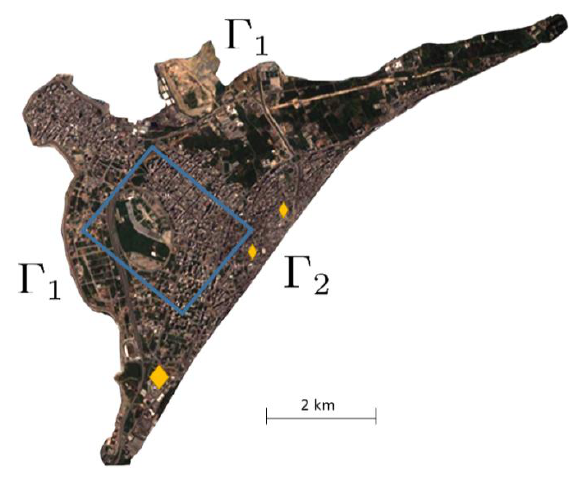
Figure 3. The lower zone of Tripoli city with the location of the pumping zone.